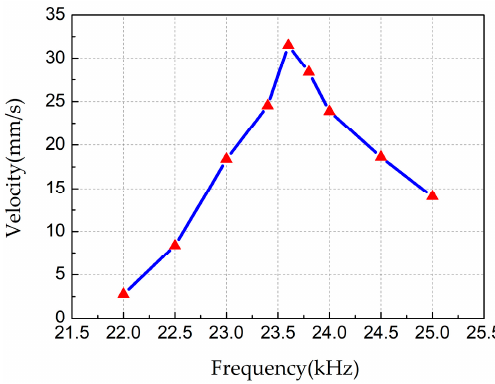
Figure 8. Plot of the output velocity versus different input frequencies.